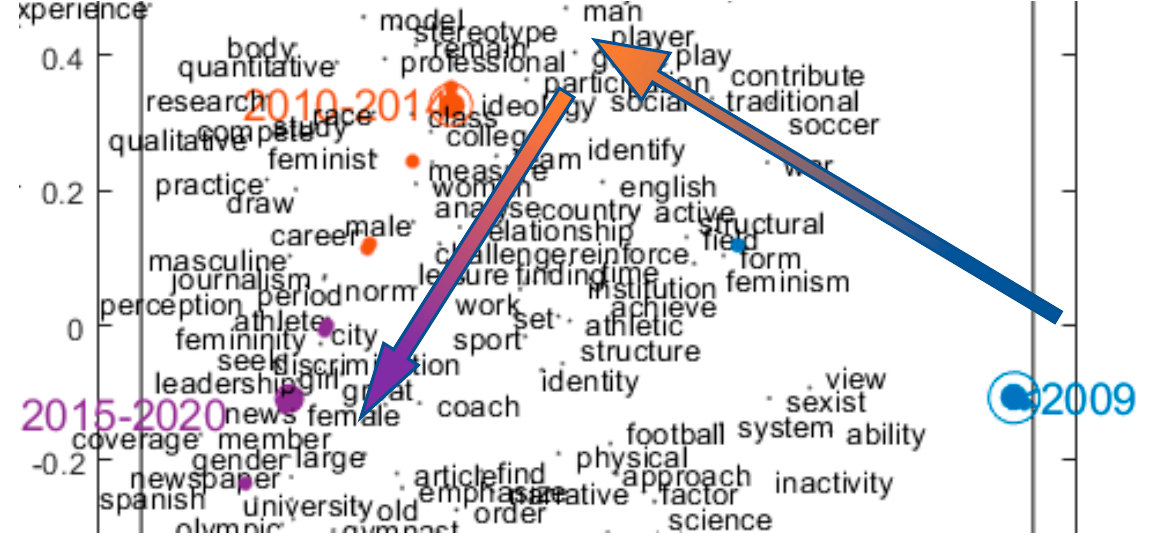
Figure 6. Evolution of the literature of inequalities in women’s sport.